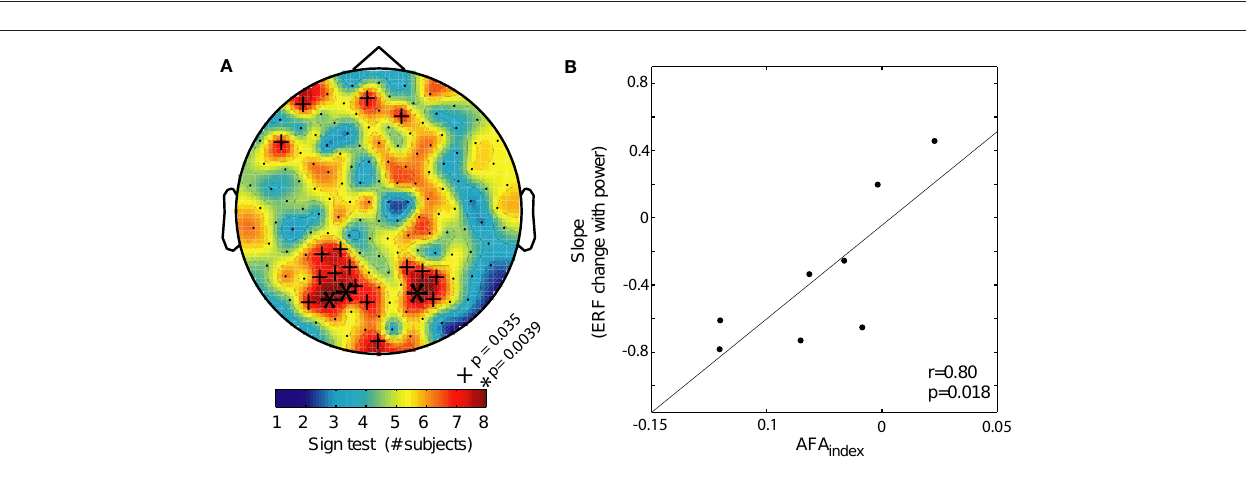
Figure 6 | The AFA can used to predict the polarity and magnitude of index evoked responses. (A) The consistency between the sign of the AFA eyes closed data) and the sign of the modulation in slow visually evoked ERF with alpha power. The color code represents the number of consistent signs over the eight subjects. More than six consistent signs are considered